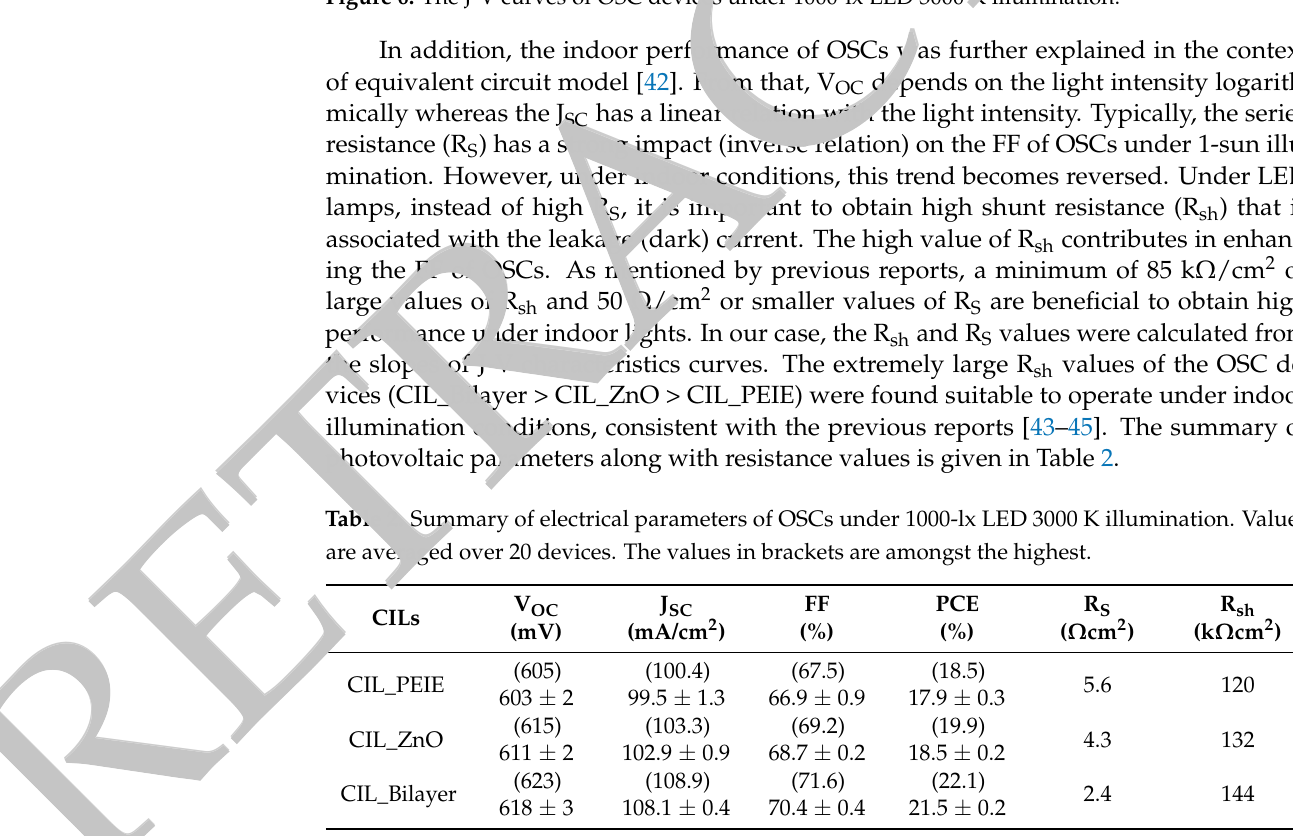
Figure 6. The J-V curves of OSC devices under 1000-lx LED 3000 K illumination.